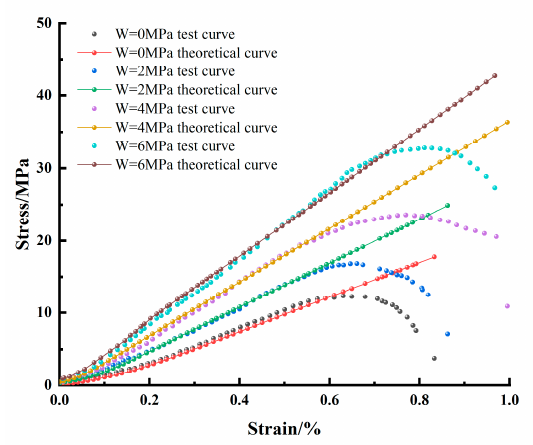
Figure 12. Comparison between experimental data and model data.